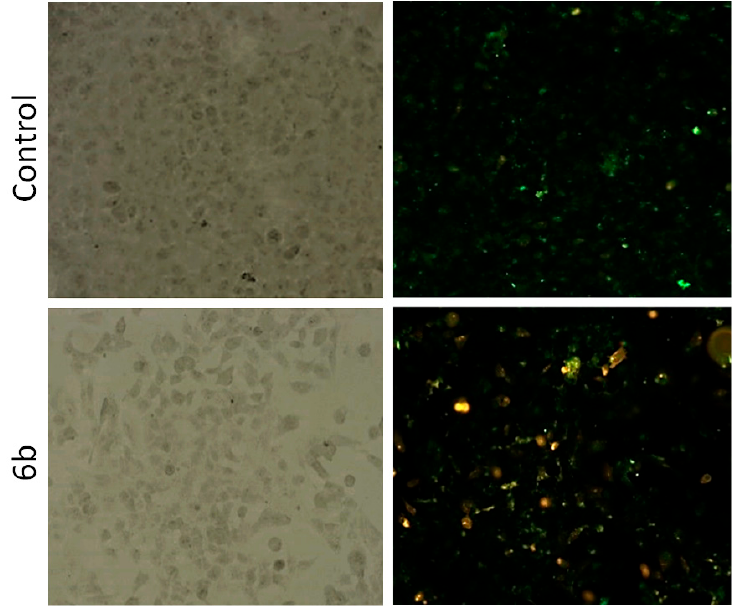
Figure 7. Detection of apoptosis induced by compound 6b in human pancreatic adenocarcinoma CFPAC-1 cell line using Annexin V-FITC assay. Cells were visualized by fluorescence microscope at